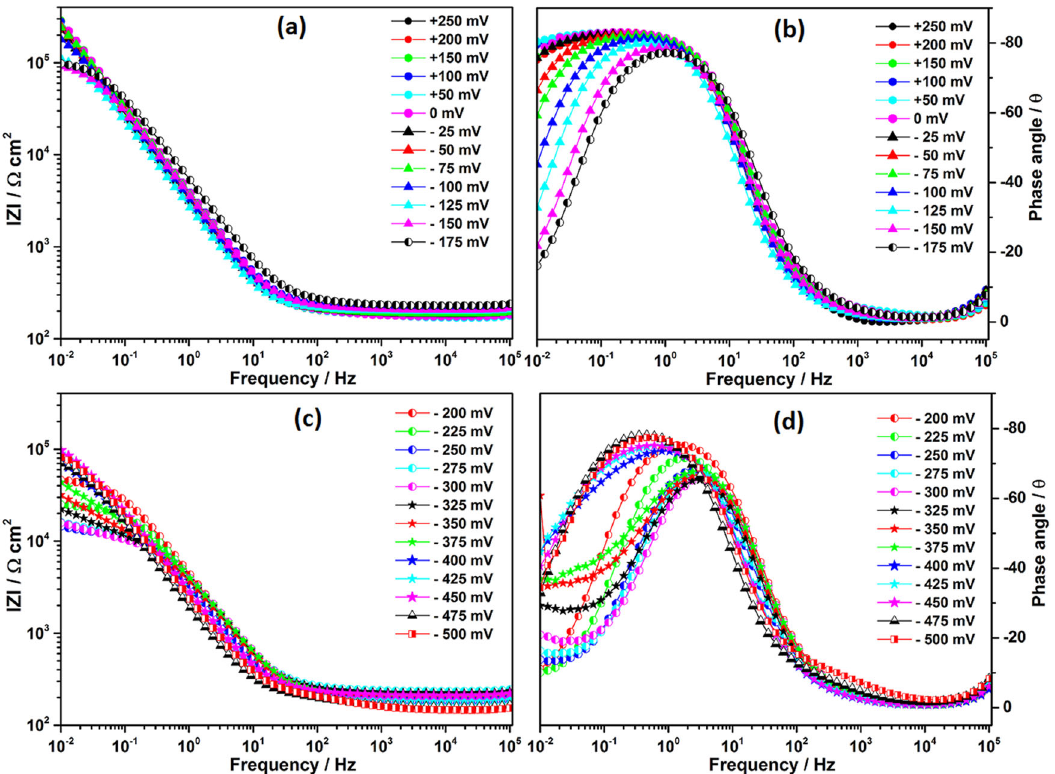
Fig. 9 Bode plots of CFRP at various polarizations. Bode plot of EIS spectra of CFRP in 50 mM NaCl at different polarizations between + 250 and − 500 mV SCE to monitor diffusion